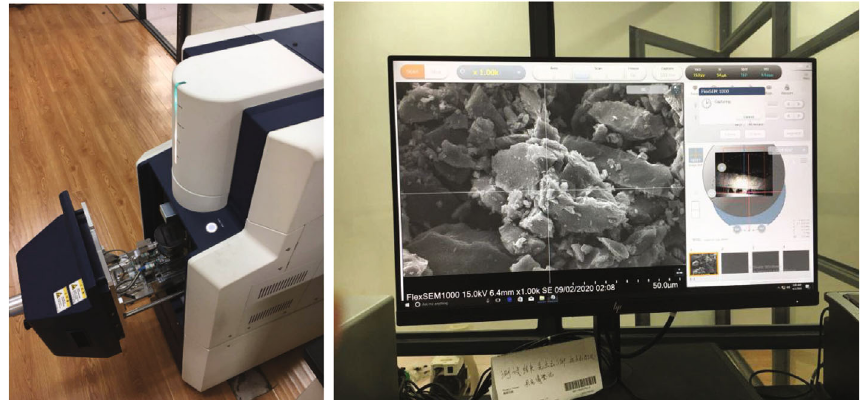
Figure 3: Test coal sample and scanning electron microscope.